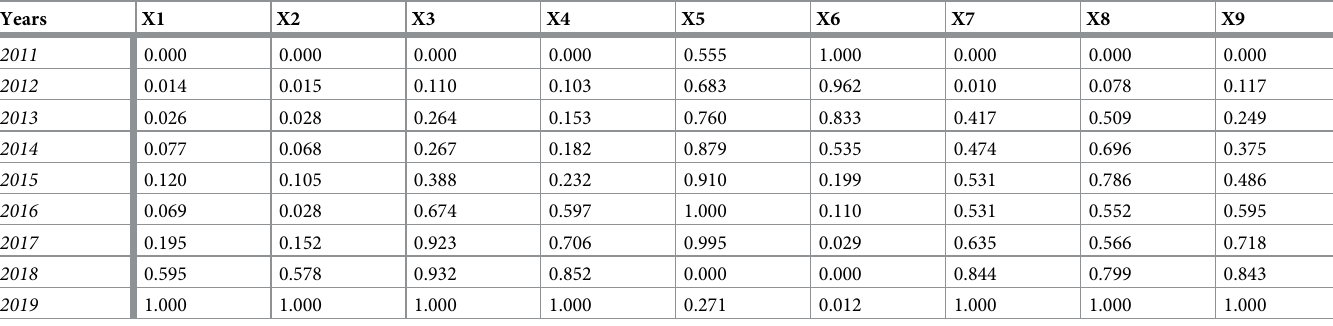
Table 4. Indicator data standardization table of Shandong Province from 2011 to 2019.